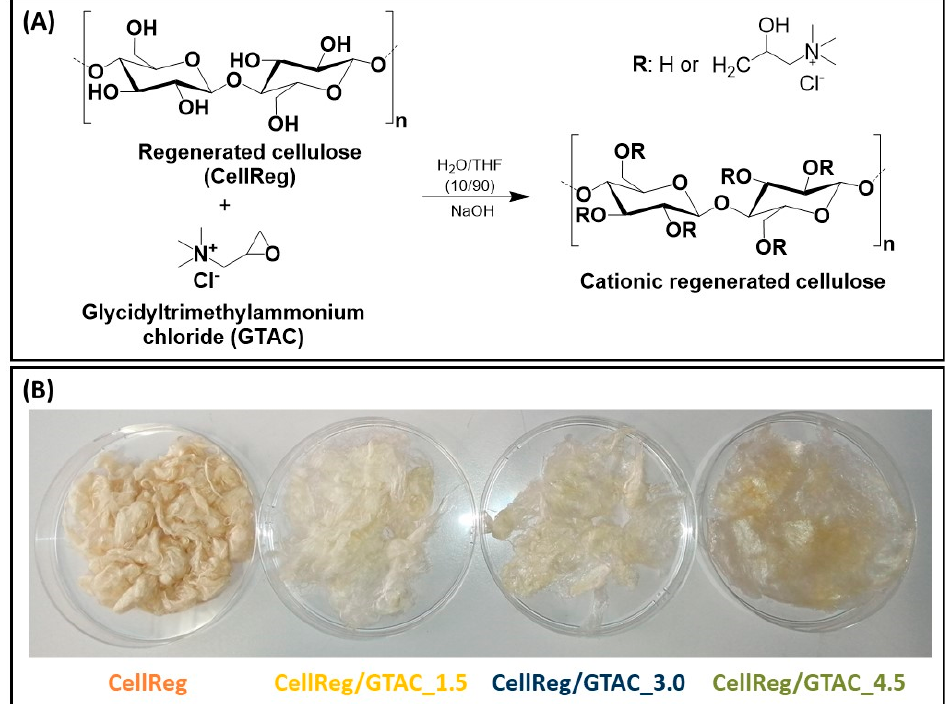
Figure 1. ( A ) Reaction scheme of the cationization of cellulose with glycidyltrimethylammonium chloride (GTAC), and ( B ) digital photographs of the non-modified and modified regenerated cellulose fiber samples: CellReg, CellReg/GTAC_1.5, CellReg/GTAC_3.0 and CellReg/GTAC_4.5.